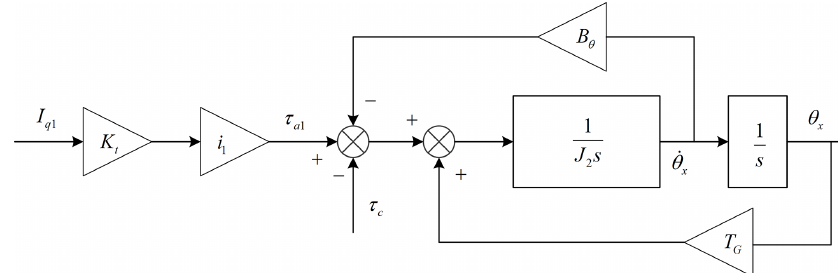
Figure 11. Structural block diagram of motor driven haptic interface.